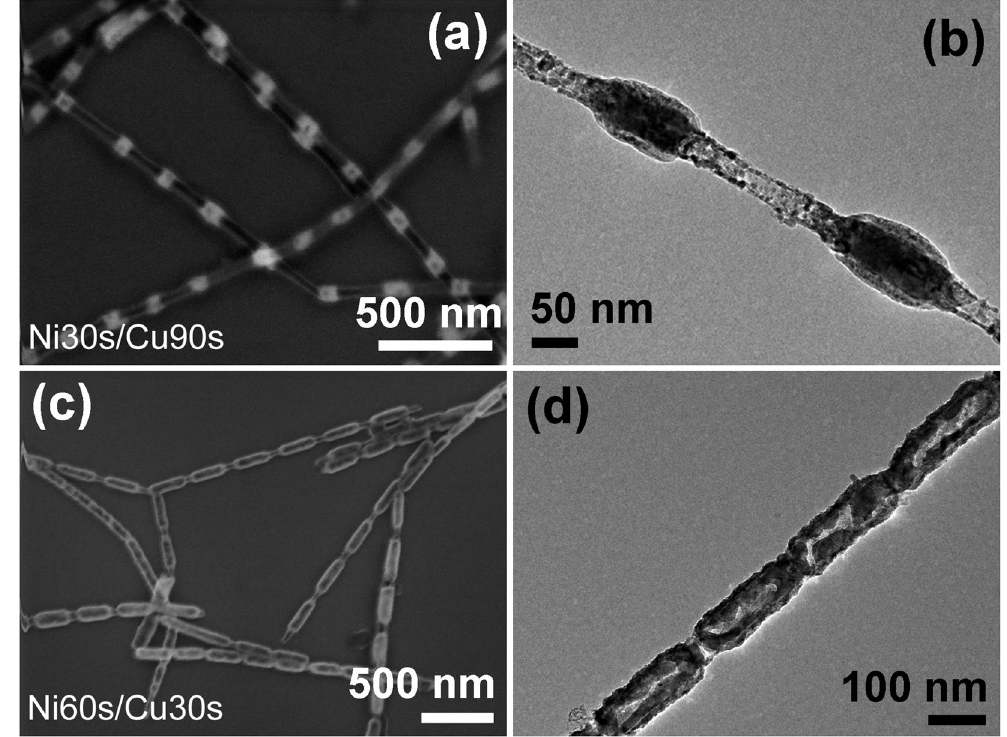
Figure 6. Morphology characterization with changes of Cu segment lengths. The SEM image ( a ) and TEM image ( b ) of sample Ni30s/Cu90s after annealing at 700 °C for 2 h in air, respectively; The SEM image ( c ) and TEM image ( d ) of Ni60s/Cu30s after annealing at 700 °C for 2 h in air,